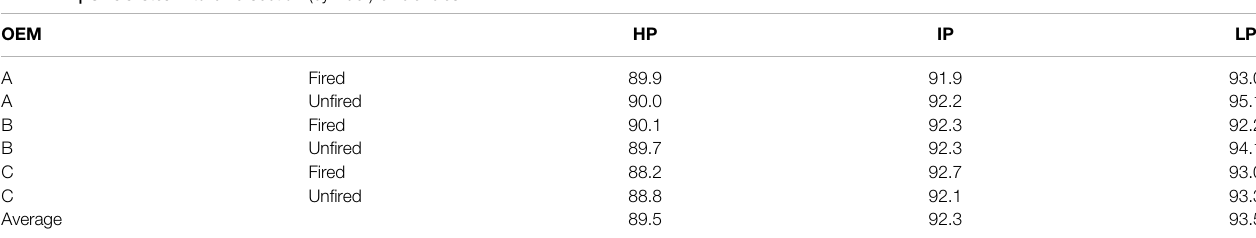
TABLE 7 | GTCC steam turbine section (cylinder) ef fi ciencies. OEM